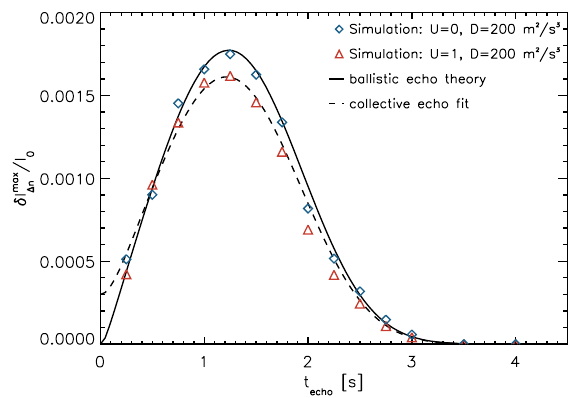
FIG. 6. (Color) Comparison of the maximum echo amplitude obtained from the simulation ( U (cid:2) 0 versus the echo time t echo blue diamonds, U (cid:2) 1 red triangles), from the ballistic echo theory for finite D (solid line), and from the amplitude fit to the collective echo theory (dashed line).